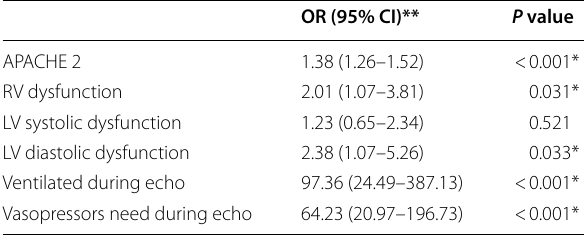
Table 4 Multivariate logistic regression analysis to predict 30-d